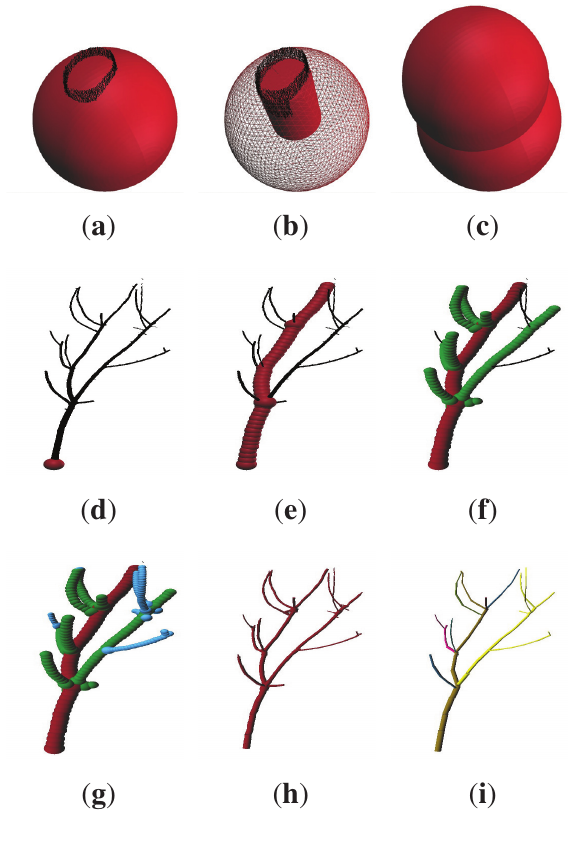
Visualization of the method in detailed steps; a branch of Group I is